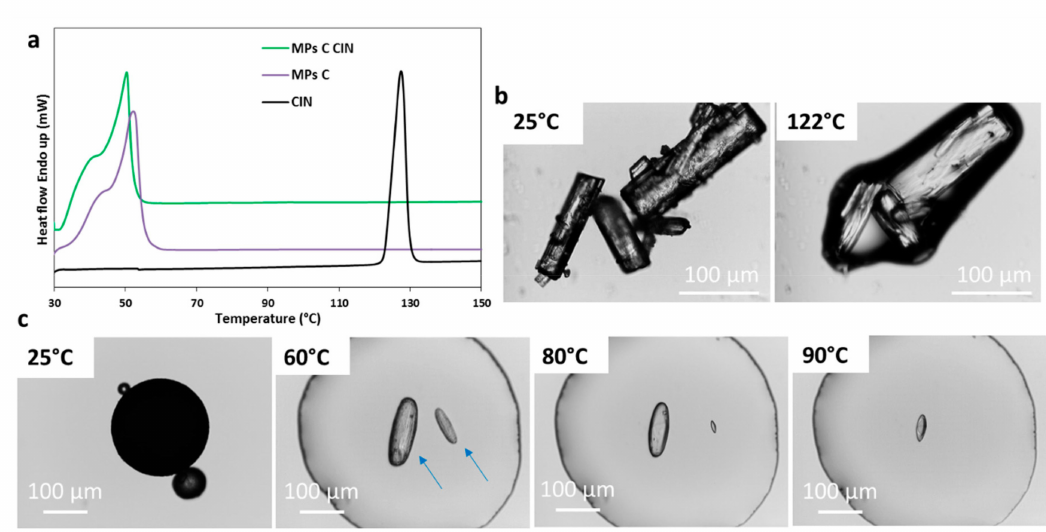
Figure 8. ( a ) DSC of CIN, unloaded MPs C, and MPs C CIN; ( b ) HSM images of CIN; ( c ) HSM images of MPs C